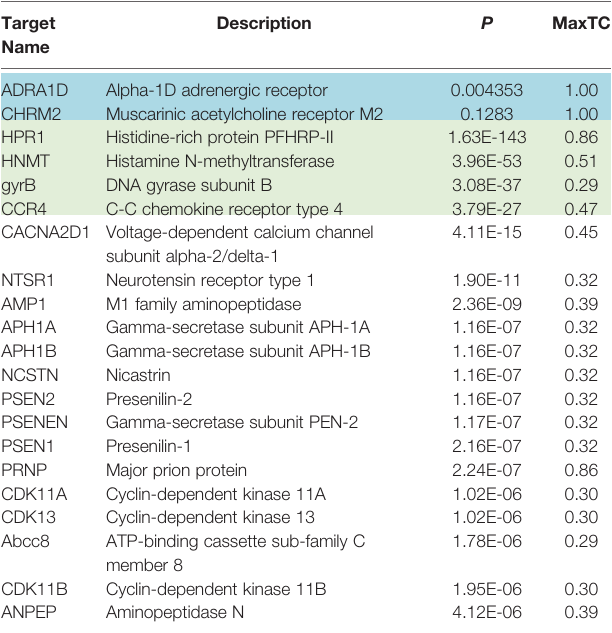
Results highlighted in blue indicated veri fi ed hits in vitro. Targets highlighted in green are considered to be statistically signi fi cant (p < 1.000E-15). Results in white indicate predicted targets that are not considered to be statistically signi fi cant by conventional